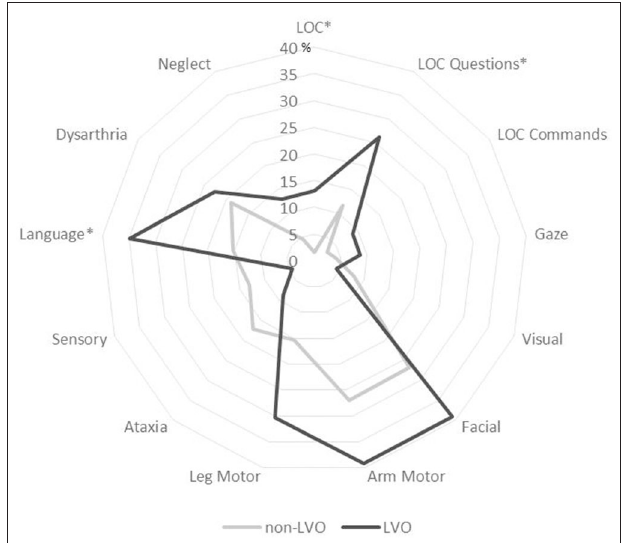
FIGURE 2 | Proportion of patients with minor ischemic stroke who have impairment in each item of National Institutes of Health Stroke Scale NIHSS score according to the presence of proximal large vessel occlusion (LVO). * p <